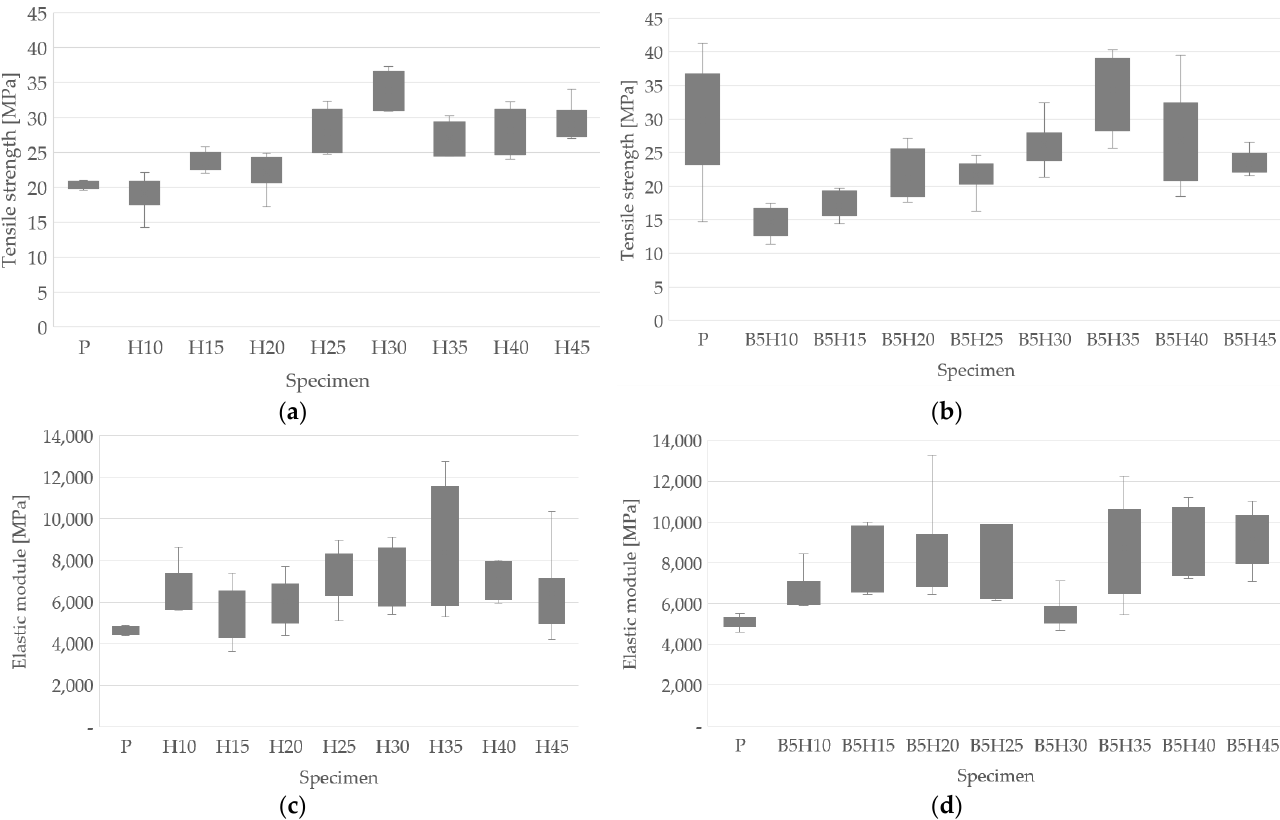
Figure 7. Tensile test results: ( a ) tensile strength of samples with addition of fibers only; ( b ) tensile strength of samples with addition of fibers and bentonite; ( c ) elastic module of samples with addition of fibers only; ( d ) elastic module of samples with addition of fibers and bentonite.